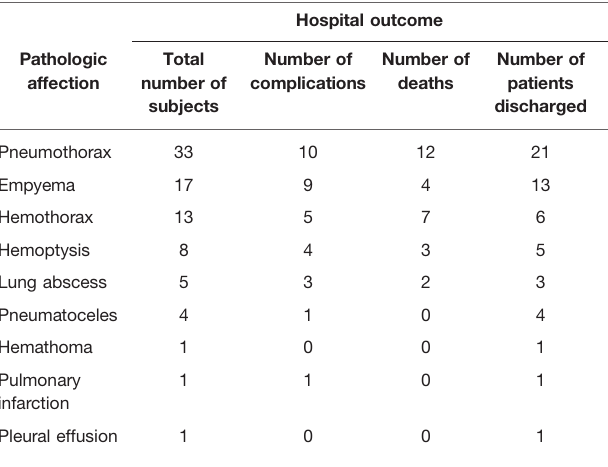
TABLE 5A | Unadjusted univariable analysis of 30-day mortality factors.